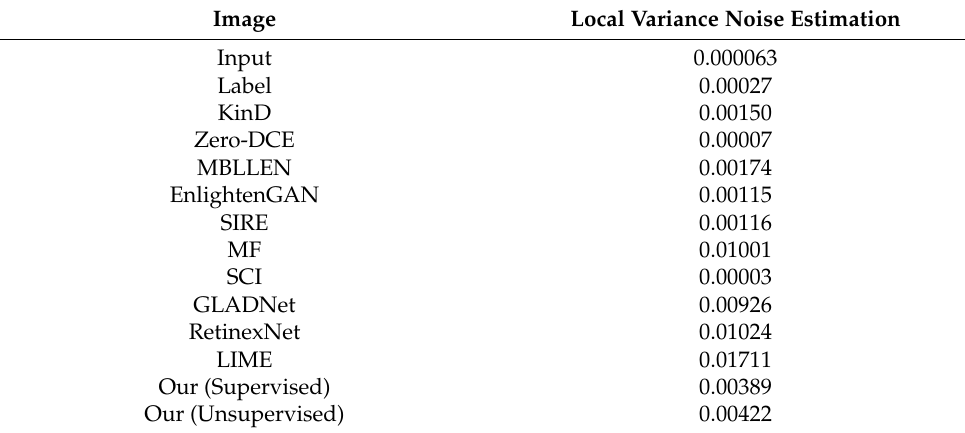
Table 6. Comparison of Image Noise Level of Different Algorithms.